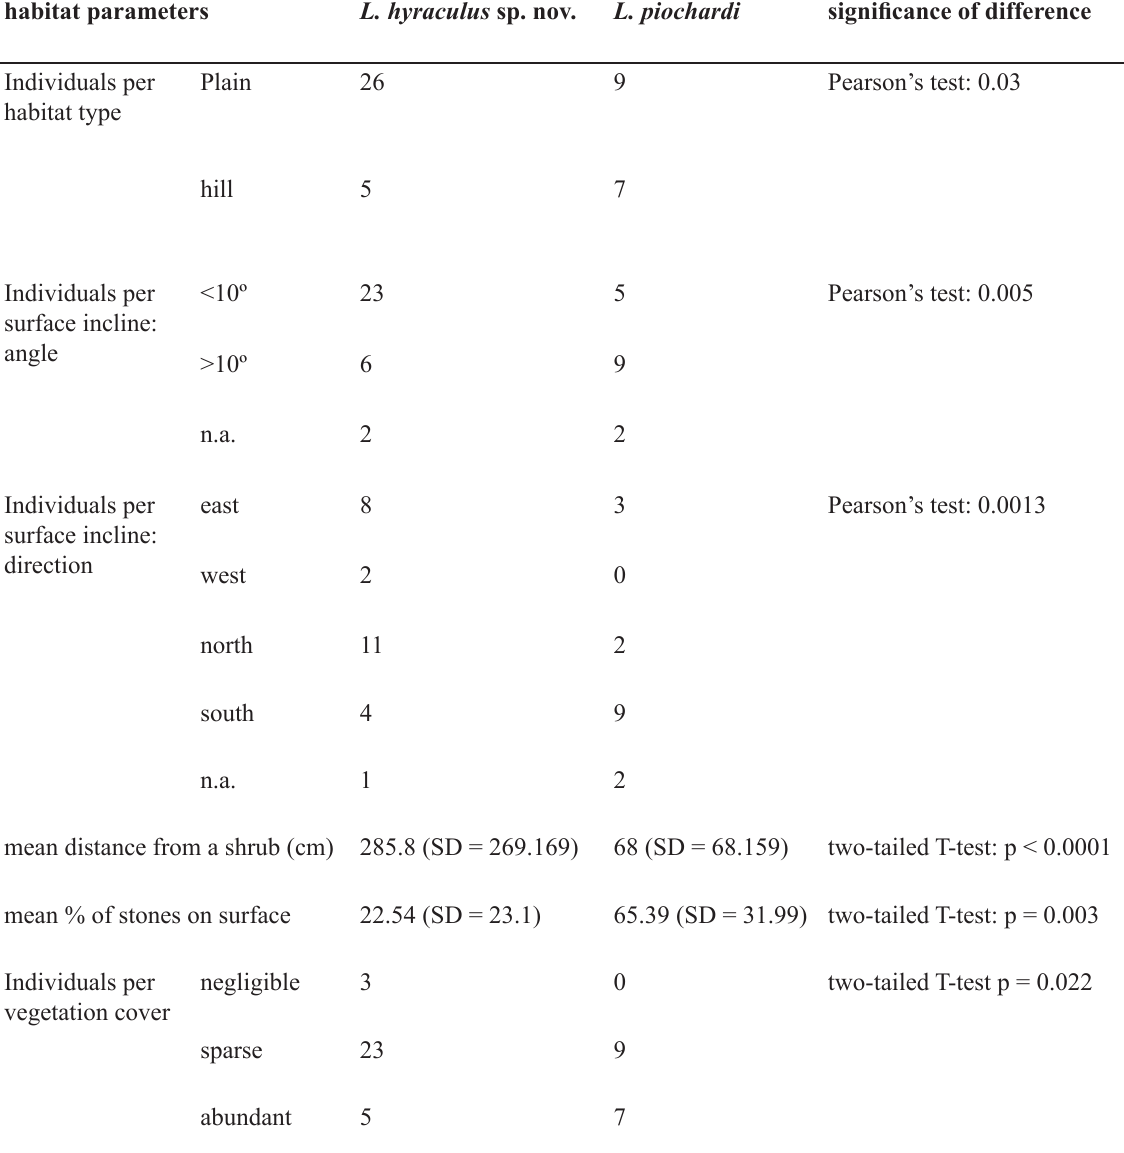
Table 5. Results of ecological survey of Lycosa spp. in the 13–14 Sep. 2020. habitat